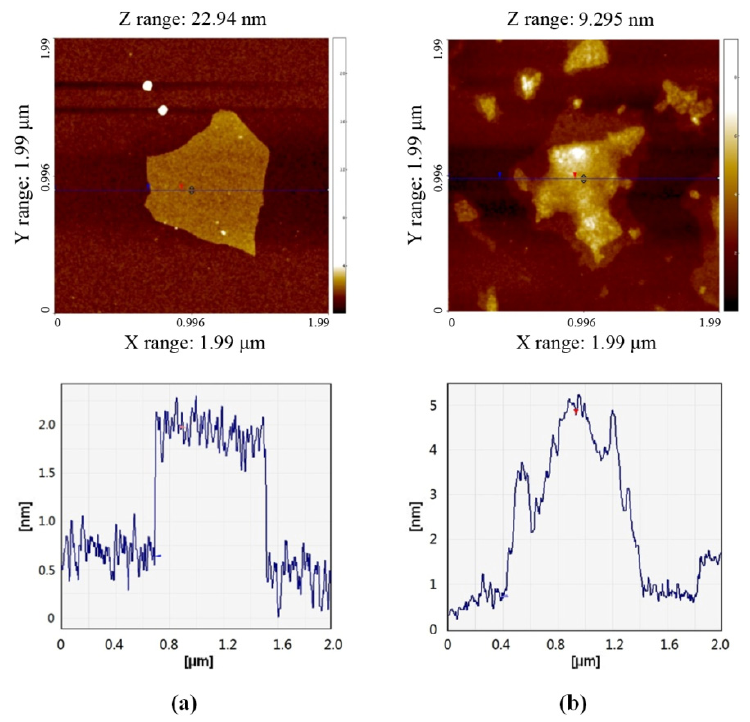
Figure 4. AFM images of GO ( a ) and GO-DOPO-V ( b ).